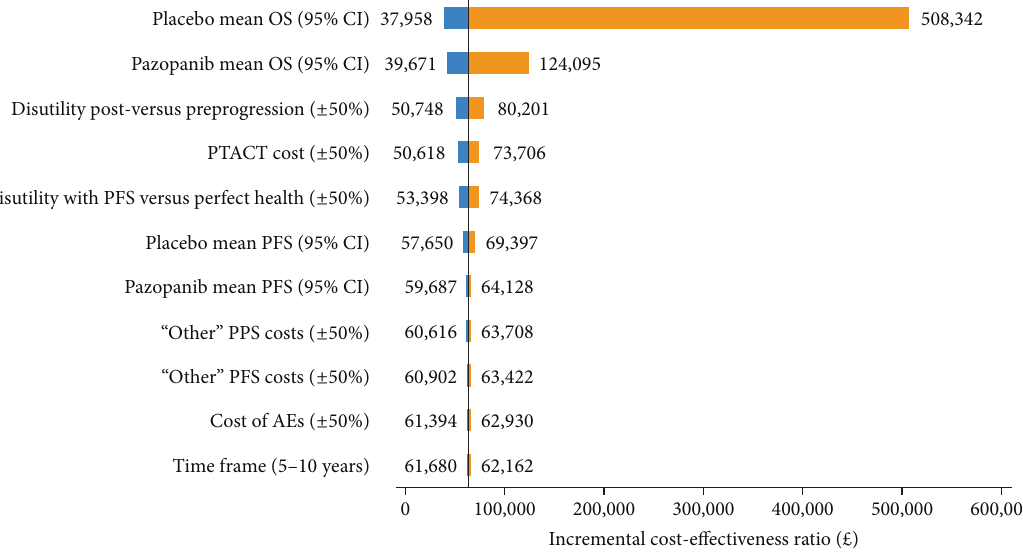
Figure 2: Tornado diagram showing result of deterministic sensitivity analysis for the direct comparison of cost-effectiveness of pazopanib versus placebo. Parameters were varied by 0.5 or 1.5 and shown on either side of the graph. AE: adverse events; CI: confidence interval; OS: overall survival; PFS: progression-free survival; PPS: postprogression survival; PTACT: posttreatment anticancer therapy.